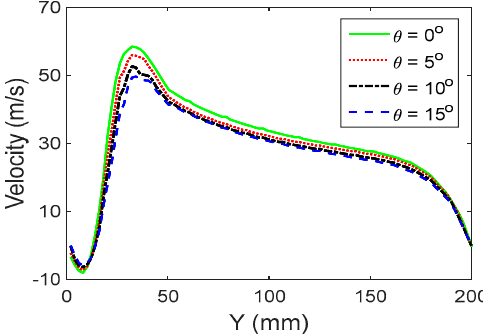
Figure 10. Velocity profiles along the y -axis when L = 30 mm.